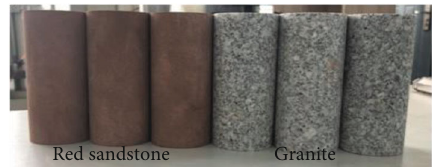
Figure 1: Sandstone and granite specimens.